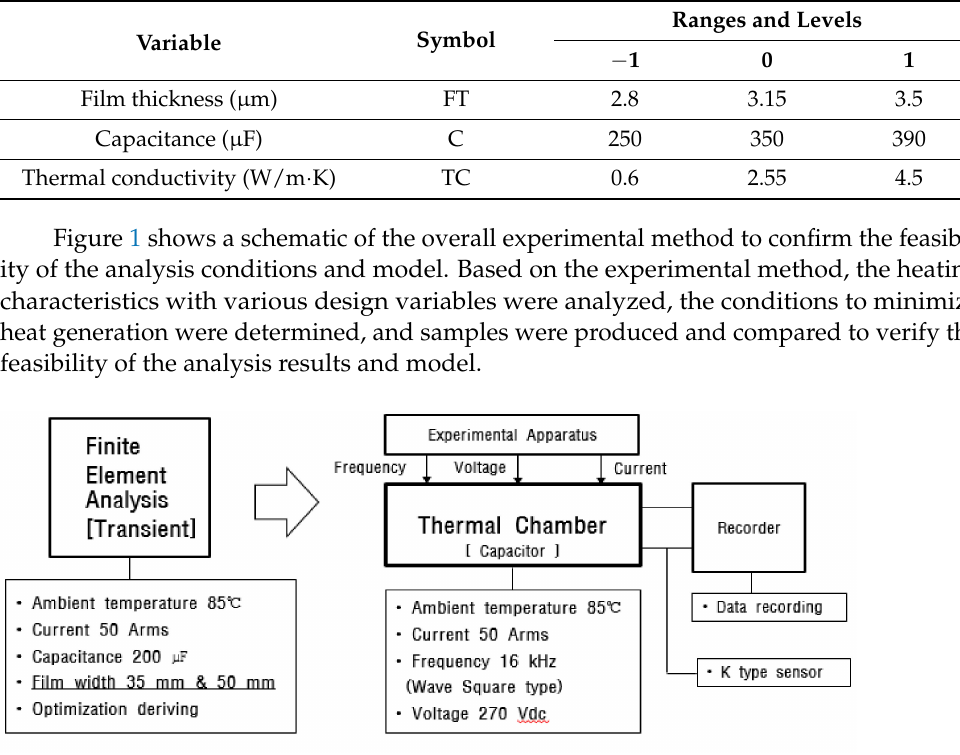
Figure 1. Schematic diagram of capacitor temperature